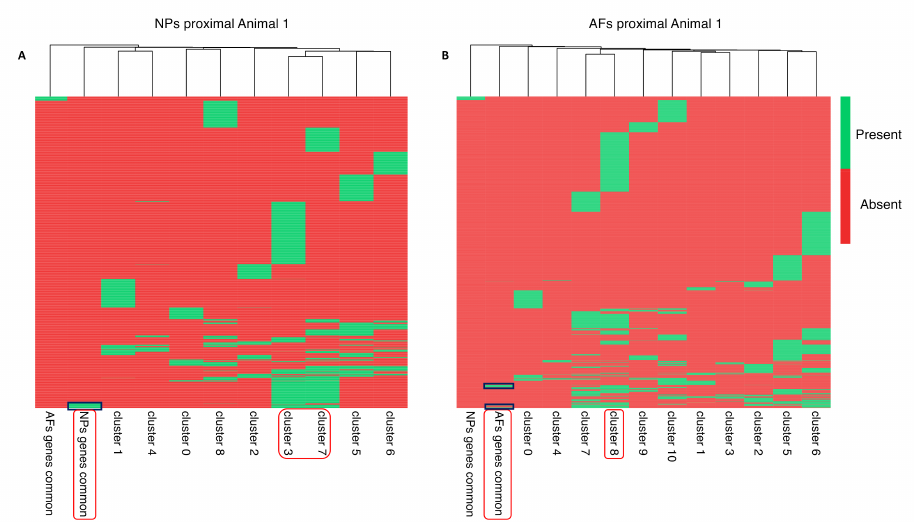
Figure 10. Heat map exclusive genes bulk and scRNAseq. Heat map of exclusive AF and NP genes common between the scRNAseq and bulk RNAseq. These genes are mapped against a single sample. ( A ) The first heat map depicts the cell clusters that express the NP common genes in the sample NPs proximal Animal 1. ( B ) The second one depicts cell clusters that express AF common genes. The dendrogram at the top is a function of the amount of commonly expressed